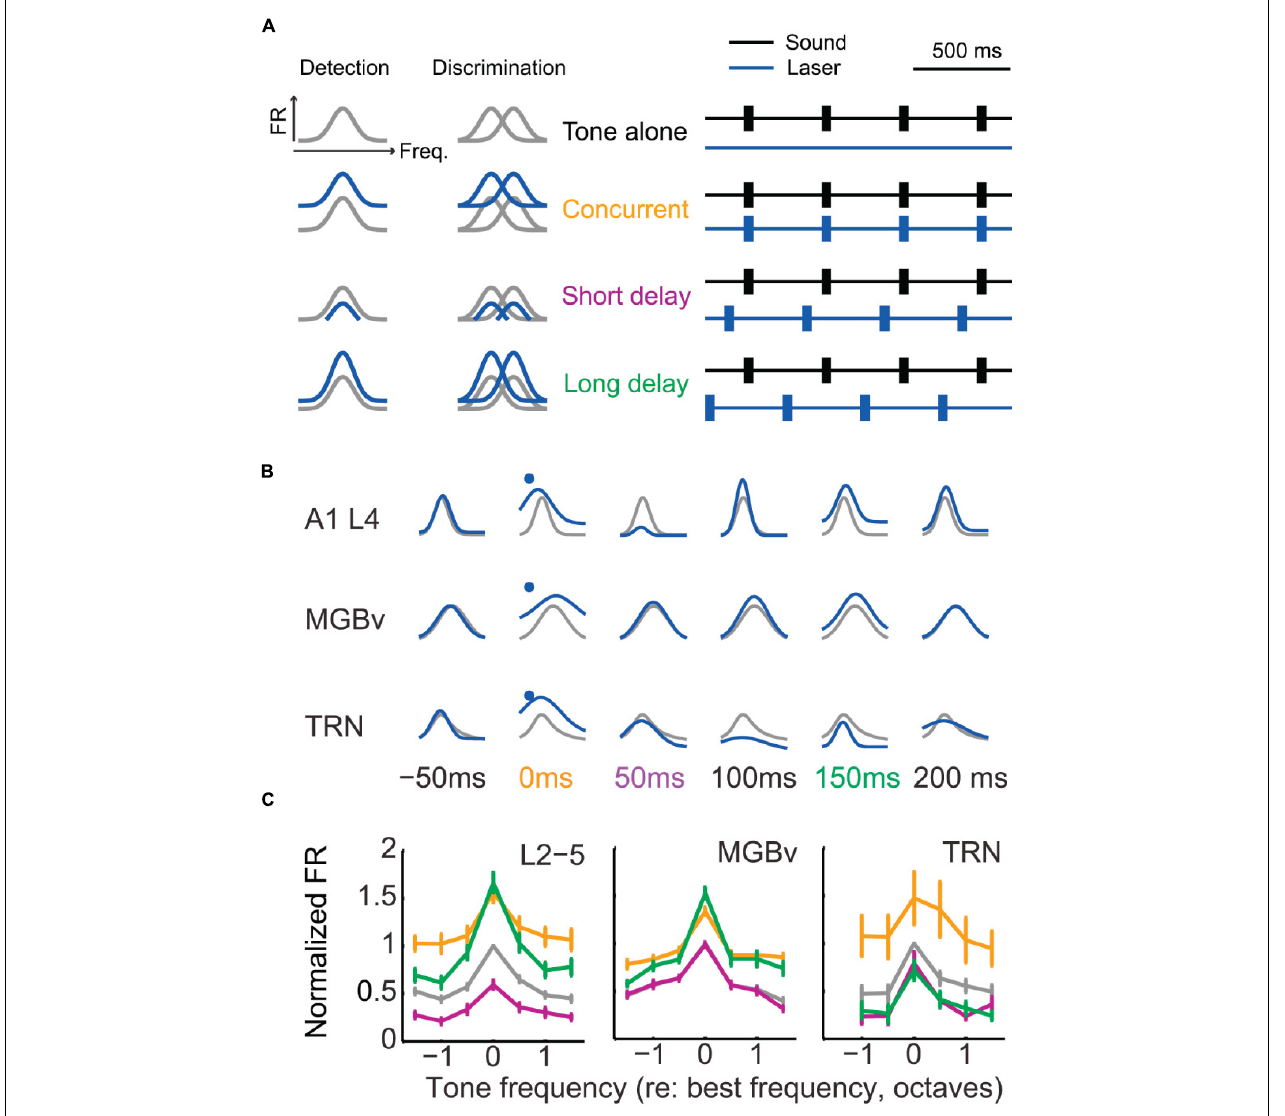
FIGURE 4 | Corticothalamic gain control on frequency tuning curves of A1, MGBv, and TRN neurons. (A) Schematic of corticothalamic modulation on the turning curves of A1 cortical neurons and optogenetic laser stimulation paradigm. Lemniscal layer VI corticothalamic neurons were activated by expressing ChR2 in A1 bilaterally in Ntsr1-Cre mice and using pulses of blue laser light. Depending on the duration of the sound stimulation delay following laser activation of corticothalamic neurons in layer VI, the tuning curves were predicted to be modulated distinctively and to define tone detection and discrimination behaviors. The animals were trained to detect or discriminate sounds using an avoidance task. (B) Representative modulation effect on the tuning curves of A1, MGBv, and TRN neurons (gray, tone-alone; blue, tone-and-laser). Sound-evoked responses enhanced in A1 and MGBv neurons for the concurrent stimulation of tones and laser (orange). For the tone presentation with a short or long delay following the corticothalamic stimulation (purple or green), corticothalamic modulation effects differed in A1, MGBv, and TRN neurons, showing enhancement for one station while showing suppression for the others. (C) Tone-evoked firing rates (mean ± SEM) were normalized and compared to the values evoked for the BF of the tone-alone condition. When tone presentation and corticothalamic stimulation were concurrent, all A1, MGBv, and TRN neurons increased firing rates (paired t test, p < 0.05). When tones were presented with a short delay following laser stimulation, the firing rates decreased in A1 and TRN neurons ( p < 0.05) but no change was found in MGBv neurons ( p > 0.05). For the long delayed condition, A1 and MGBv neurons increased firing rates ( p < 0.05), whereas TRN neurons reduced it ( p < 0.05) (Adapted and modified with permission from Guo et al., 2017; Figures 4B,